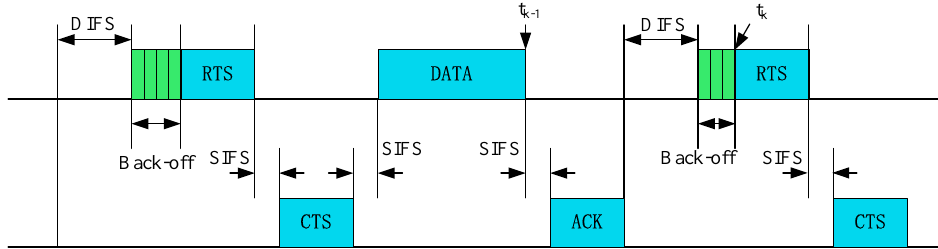
Figure 2. 802.11 Distributed Coordination Function (DCF) operation. RTS = Request to Send, ACK = Acknowledgement, CTS = Clear To Send, DIFS= distributed inter-frame spacing, SIFS = short inter-frame spacing,